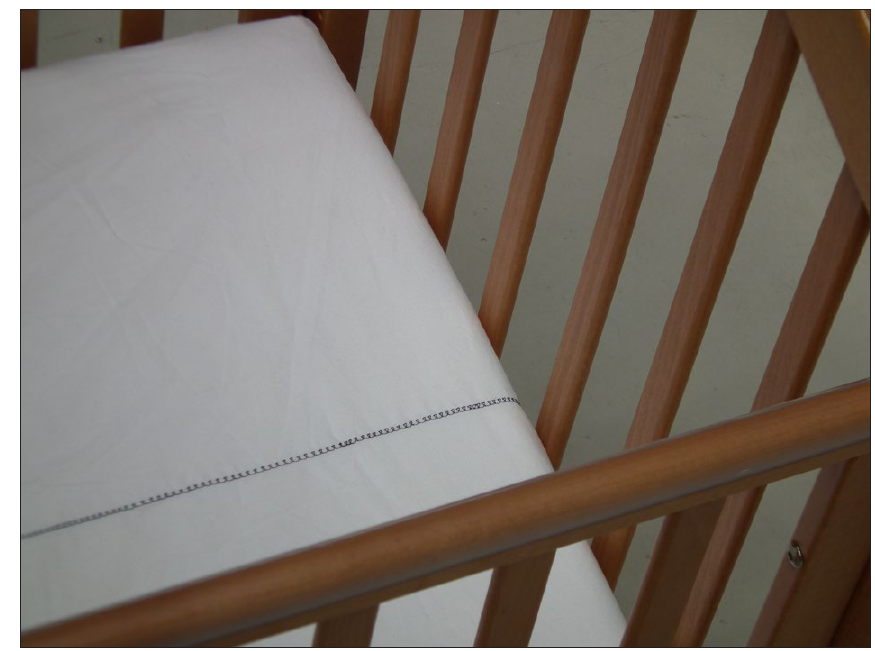
Figure 4: Elena Marchevska ‘‘ The place where we were last together ’’ 2011, installation.